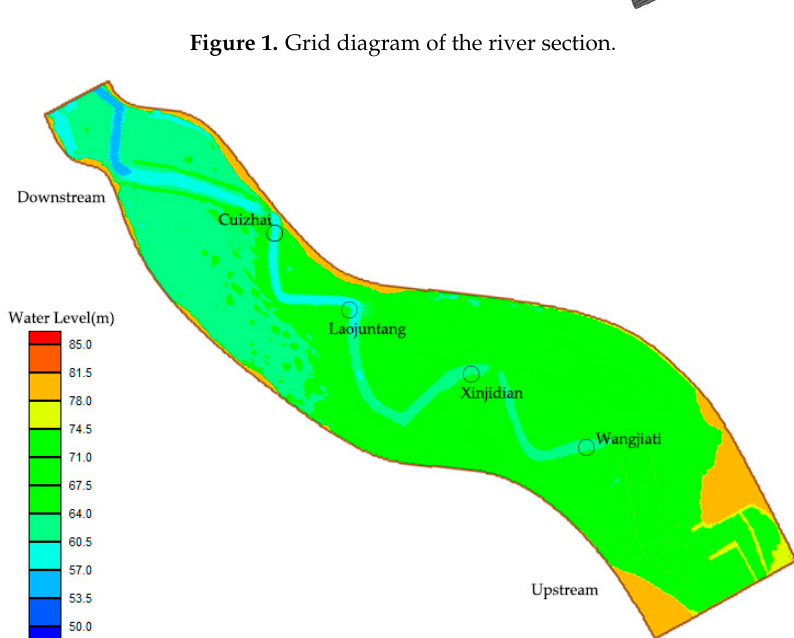
Figure 2. Discrete topographic map of the river